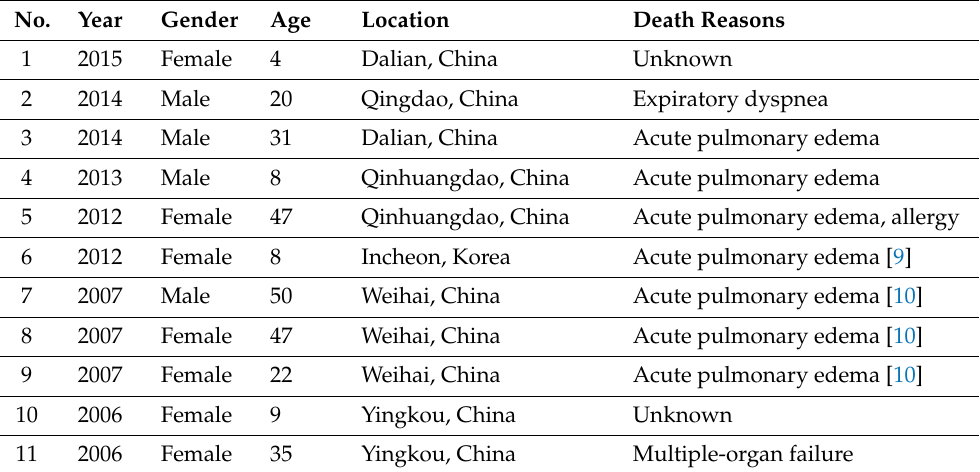
Table 1. Death reports by jellyfish N. nomurai stings in recent